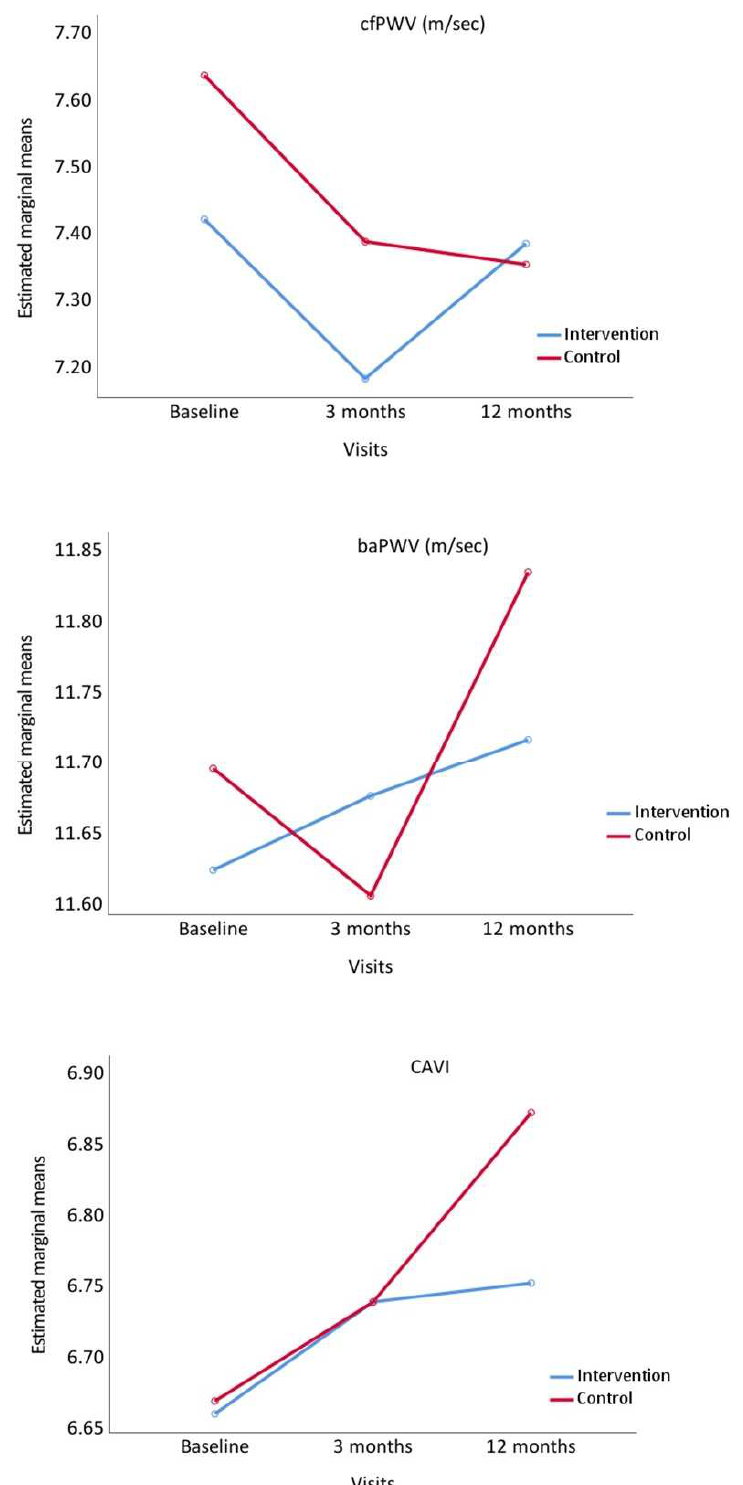
Figure 2. Evolution of carotid-femoral pulse wave velocity (cfPWV), brachial-ankle pulse wave velocity (baPWV) and Cardio Ankle Vascular Index (CAVI), from baseline to 3 and 12 months comparing the intervention and control groups. p value between groups: cfPWV, p = 0.475; baPWW, p = 0.851 and CAVI, p = 0.749.